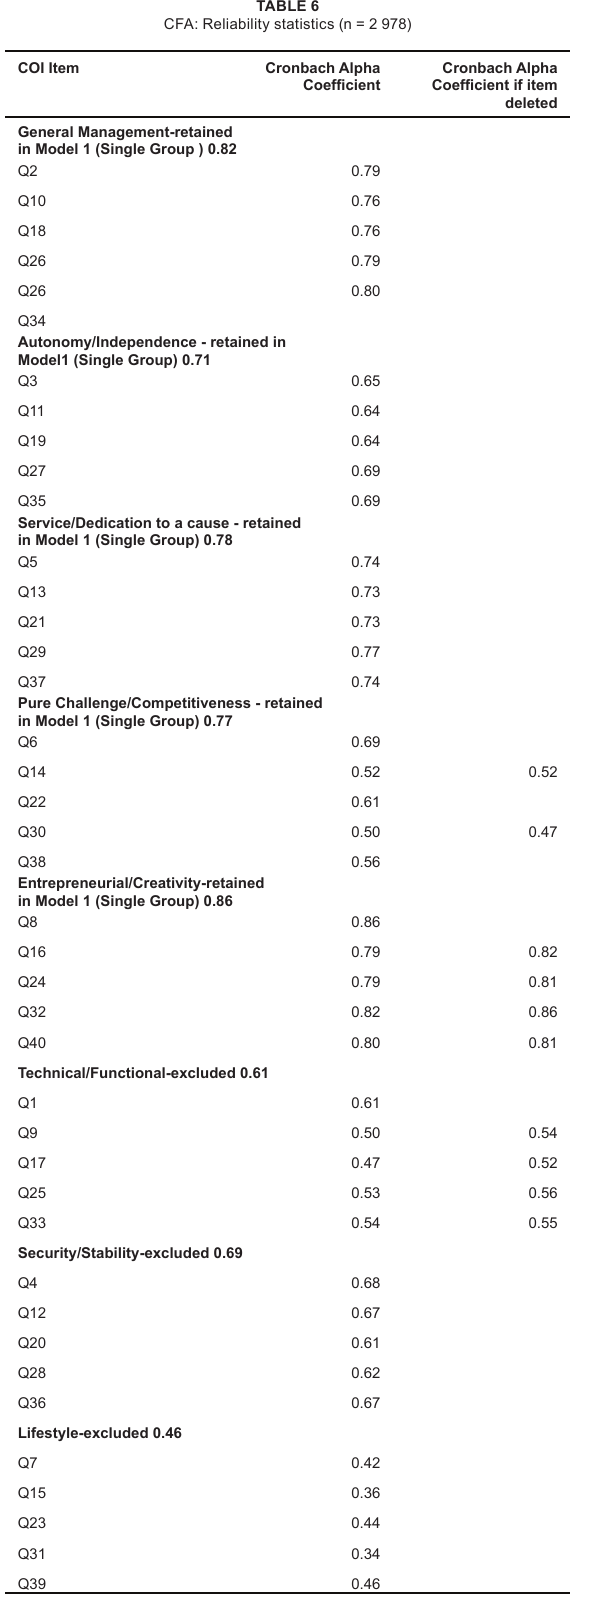
TABLE 6 CFA: Reliability statistics (n = 2